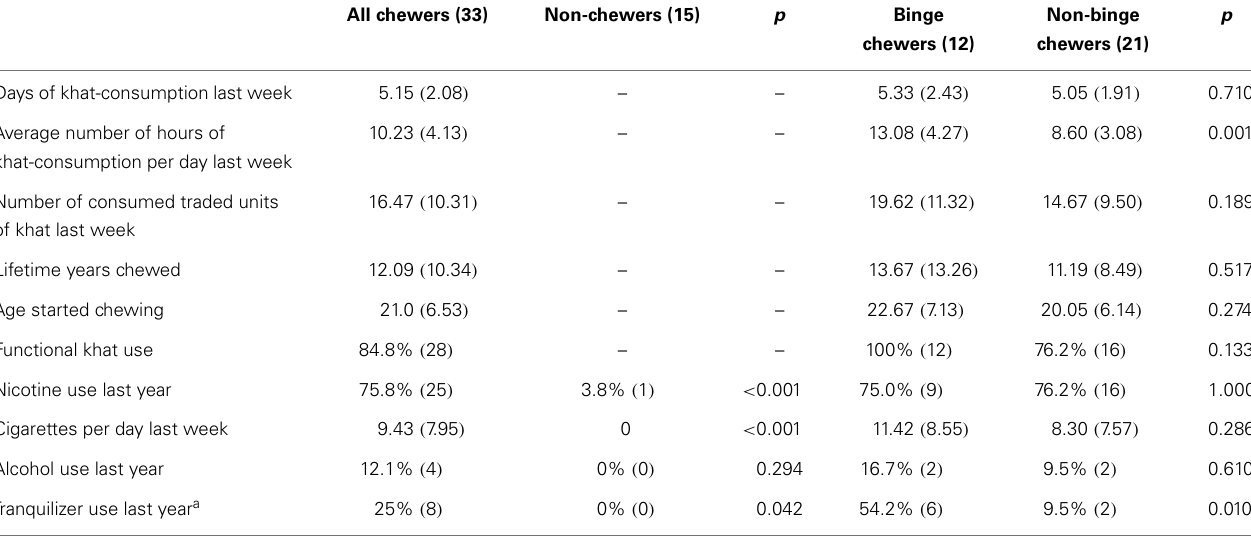
Table 2 | Patterns of khat use among chewers as well as among binge and non-binge chewers